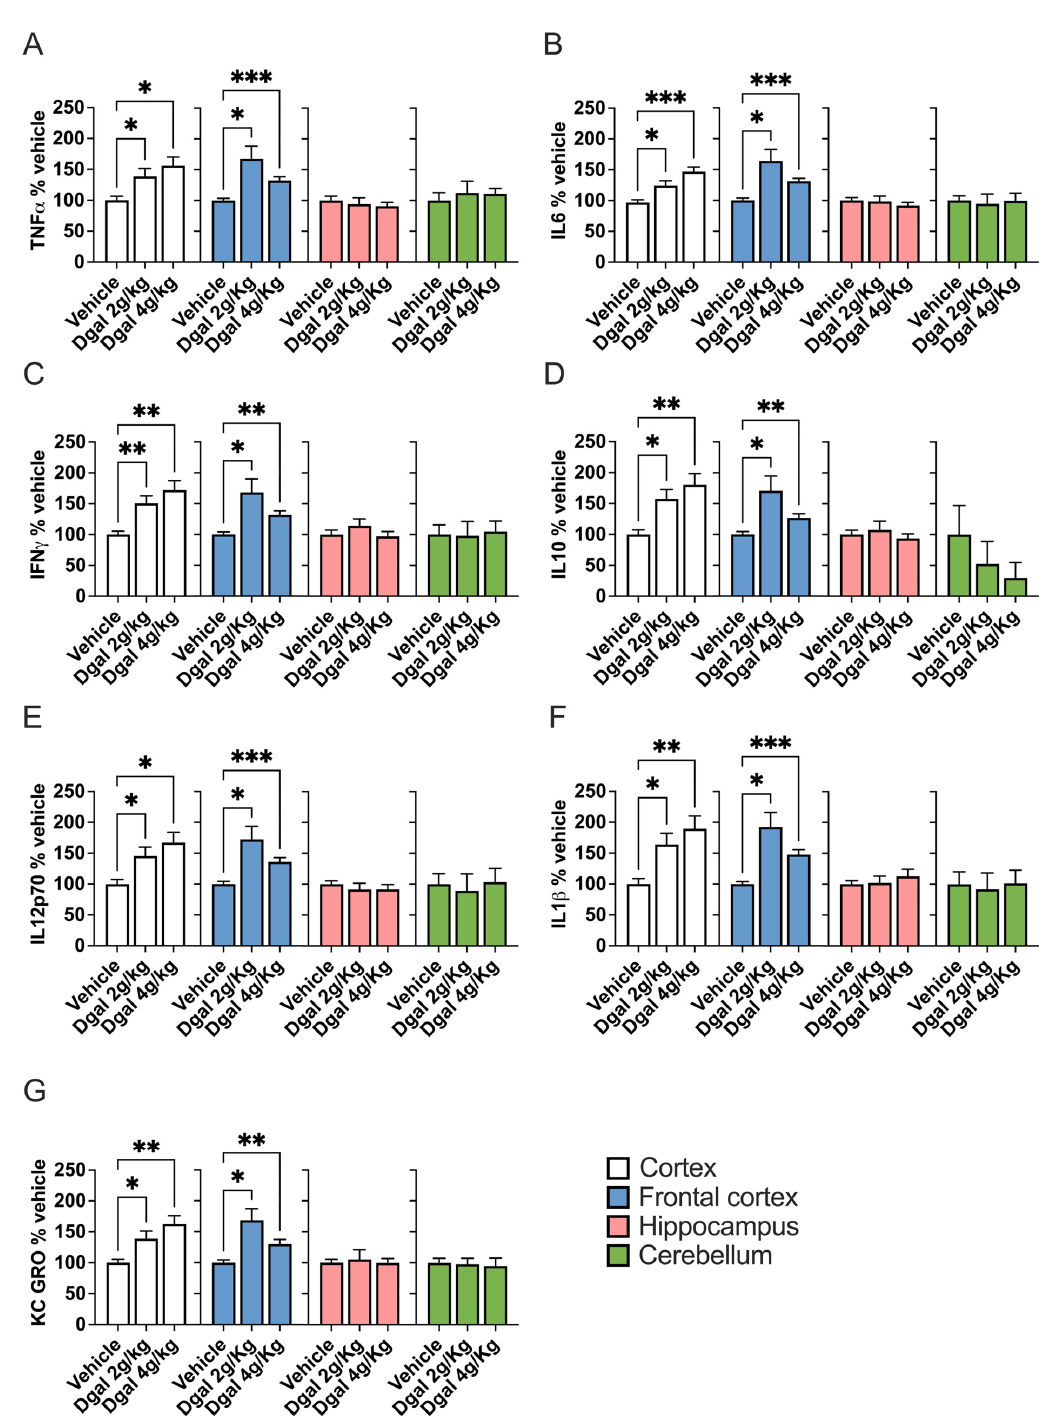
(Figure S1A,B). The ability of 2 g/kgoDGal treatment to affect performance in the NOR test but not the NOL test suggests that the perirhinal cortex is more sensitive than the hippocampus to the oDGal insult (Figure 5E,F).